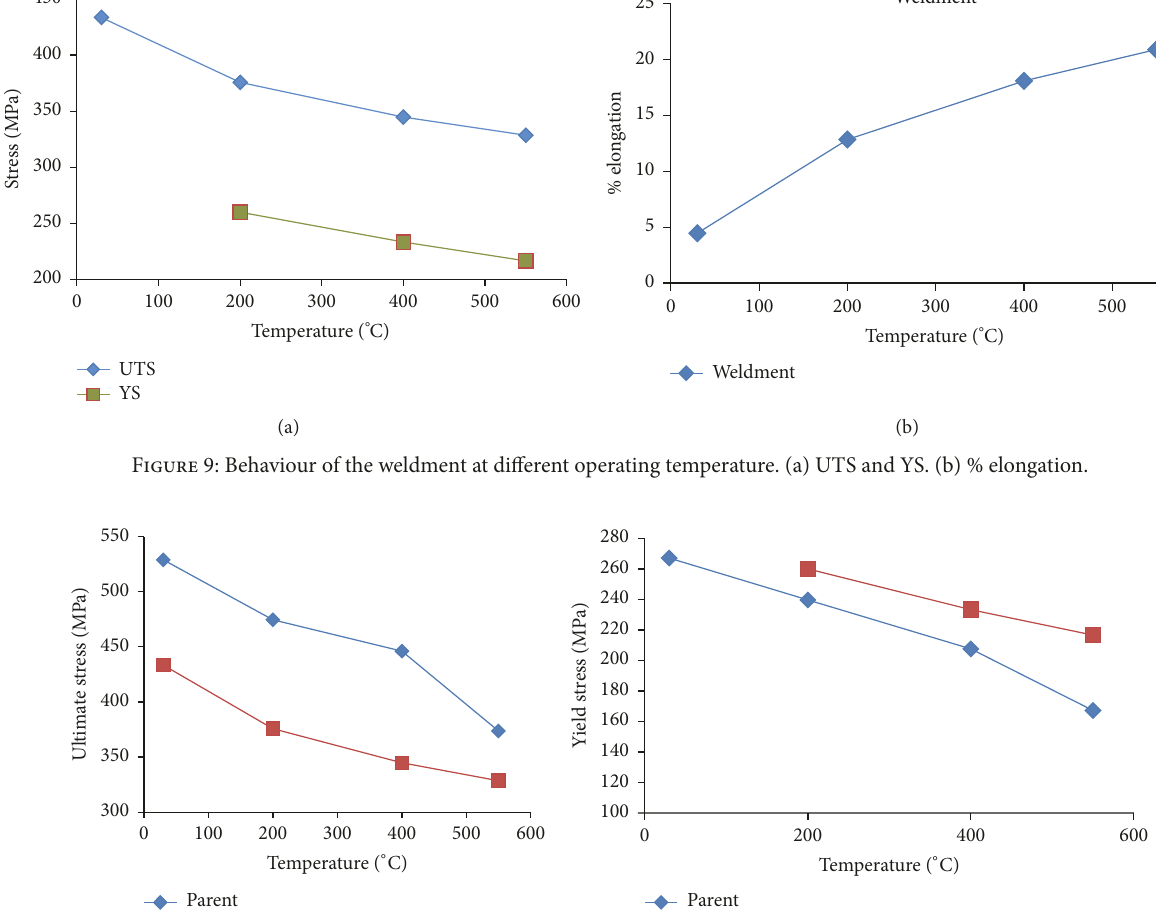
UTS decreases by 13.3%. At the normal operating temper- ature of 400 ∘ C, it decreases to 344.8 MPa, amounting to a reduction of just 8.25% compared to shutdown